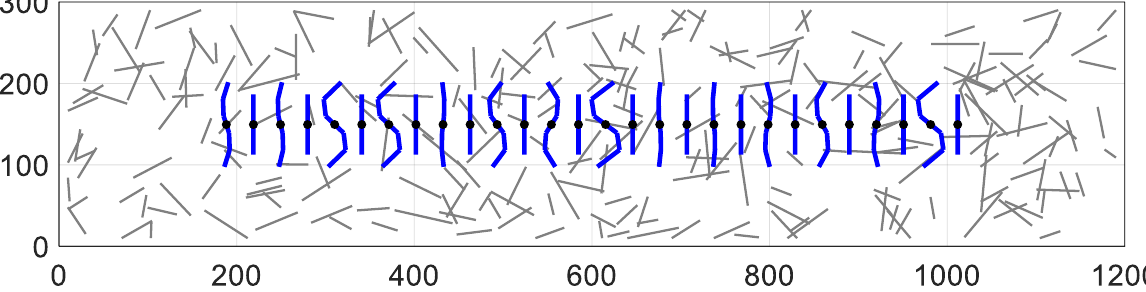
Figure 22. Scheme of simulation AE2 showing the 28 HFs and the 248 NFs.